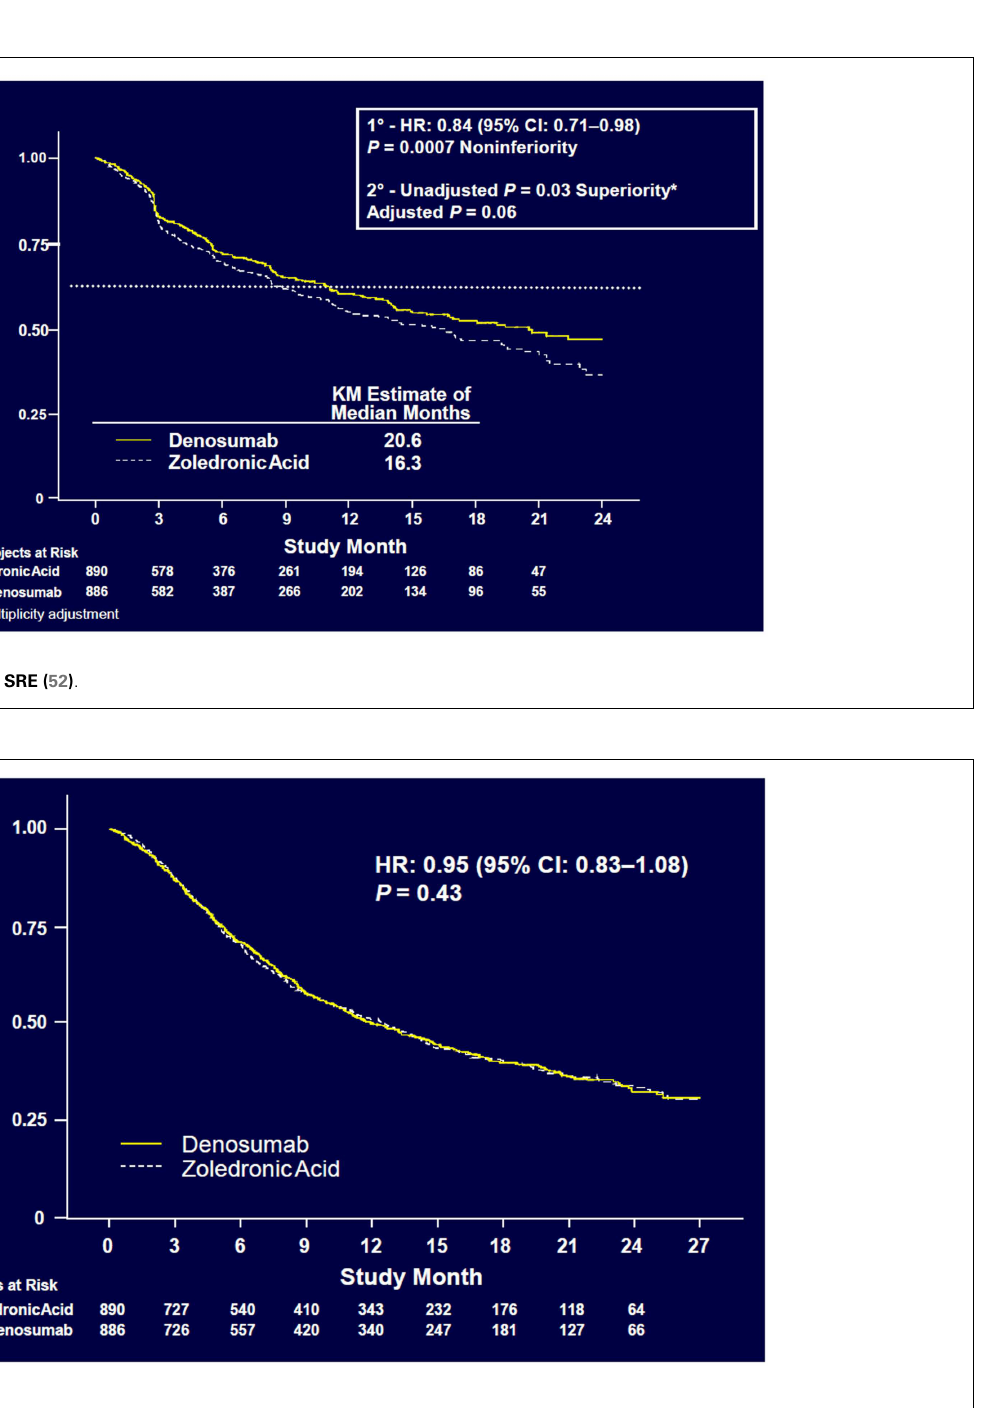
FIGURE 4 | Overall survival